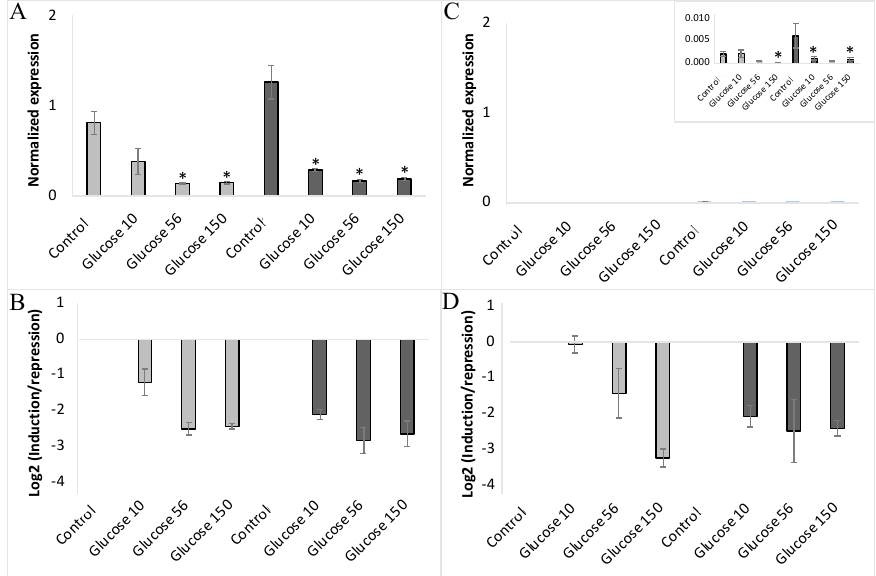
Figure 6. Expression of VvHT1 and VvHT5 in non-embryogenic cells (NEC) of wild-type cultured at three concentrations of glucose (10 mM, 56 mM and 150 mM) either in presence ( ■ ) or absence ( ■ ) of nitrates. “Glucose10”-10 mM; “Glucose56”-56 mM; “Glucose150”-150 mM. The gene expression of VvHT1 ( A , B ) and VvHT5 ( C , D ) is normalized to that of the housekeeping gene VvActin reported to the control condition used to calculate the ratio of induction/repression. Normalized expression ( A , C ) and induction/repression ( B , D ) are calculated by the methods of ∆ Ct and 2 − ∆∆ CT , respectively. The presented results correspond to the mean values of three independent experiments ( ± SEM). The asterisks denote the groups that were found significantly different by Kruskal–Wallis test (* p < 0.05) .